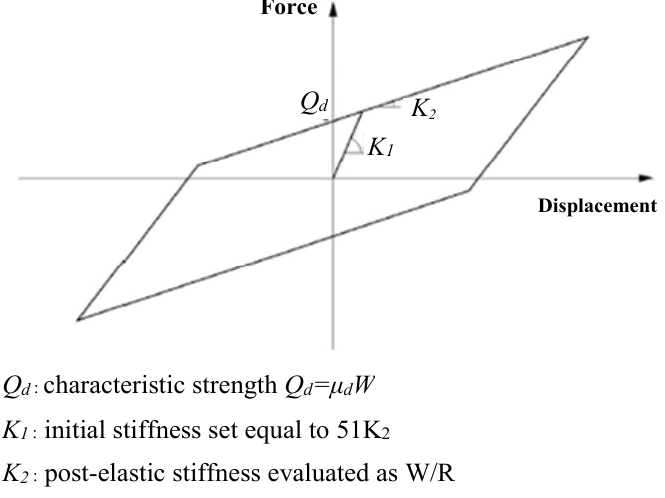
Figure 1. Non-linear hysteretic response of the single-concave friction pendulum Figure 1. Non ‐ linear hysteretic response of the single ‐ concave friction pendulum device.